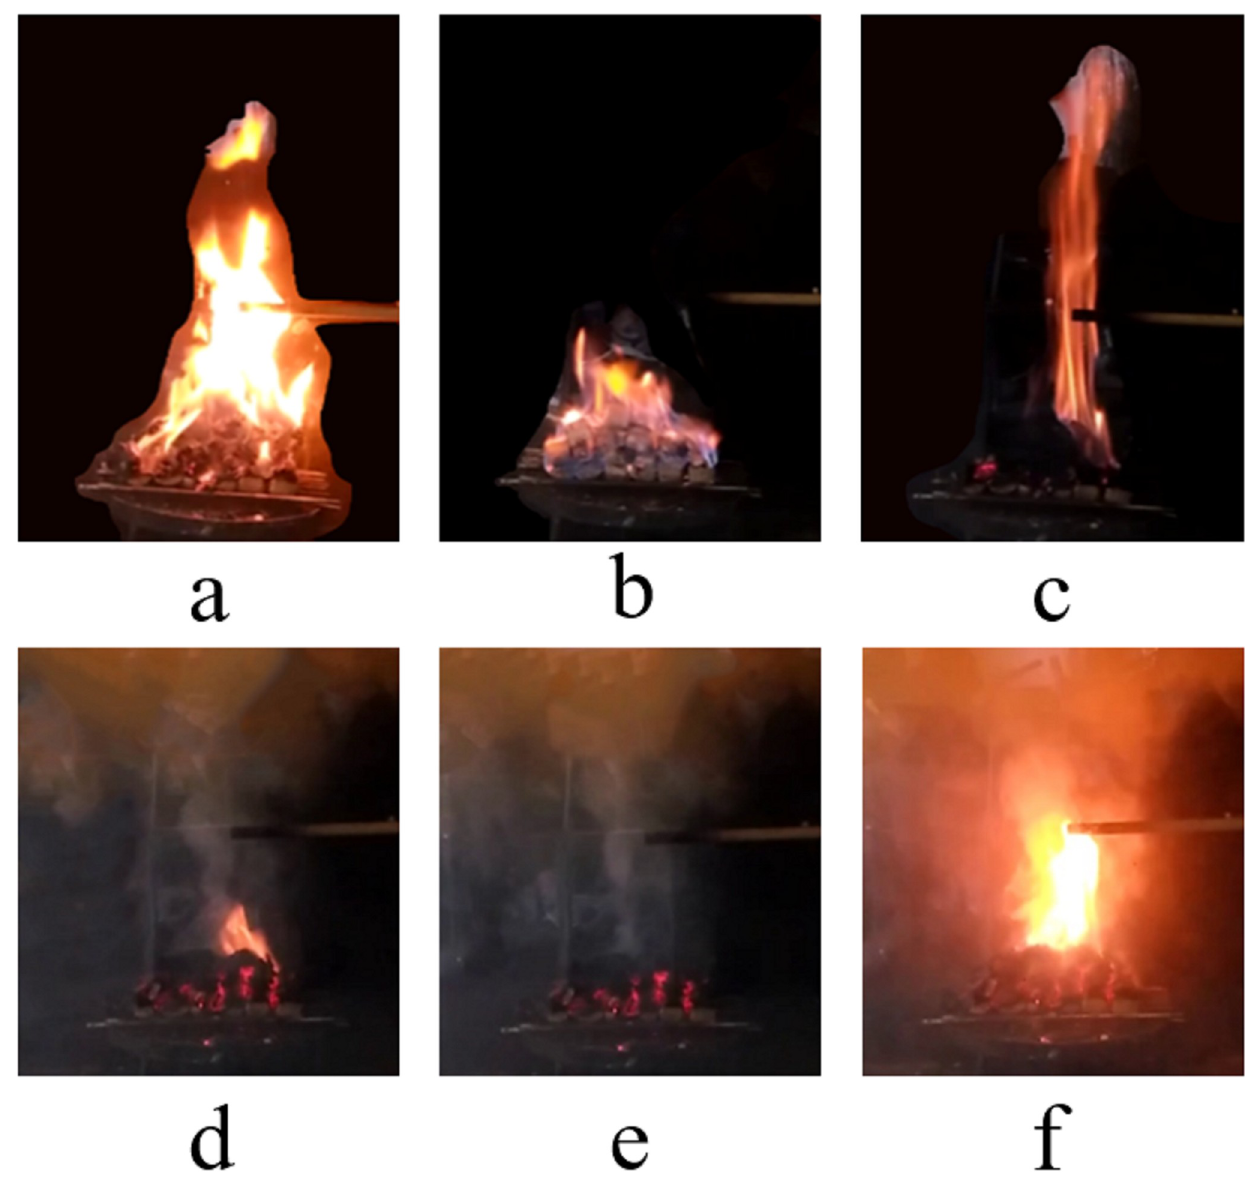
Fig 3. The flame on the surface of wood blocks of Test 8: (a) bright light blue flame; (b) bright yellow flame; (c) vertical flame; (d) intense smoldering and appearance of high temperature area; (e) appearance of flame (f) rapid covering of flame on the surface of the wood blocks.